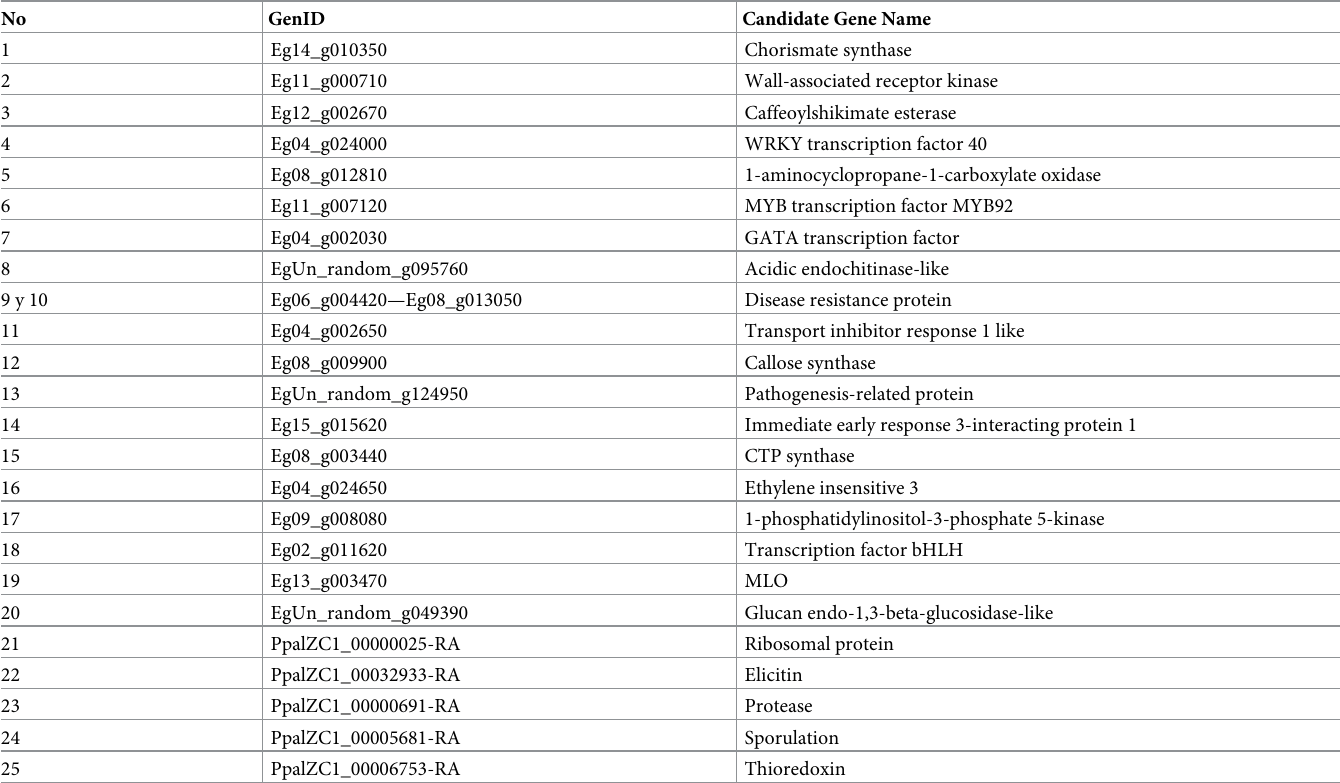
Table 2. List of validated genes for